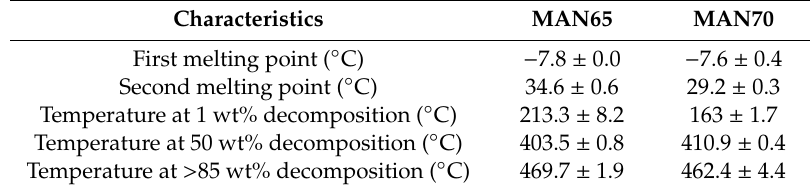
Table 4. The thermal characteristics of oil from thraustochytrids (MAN65 and